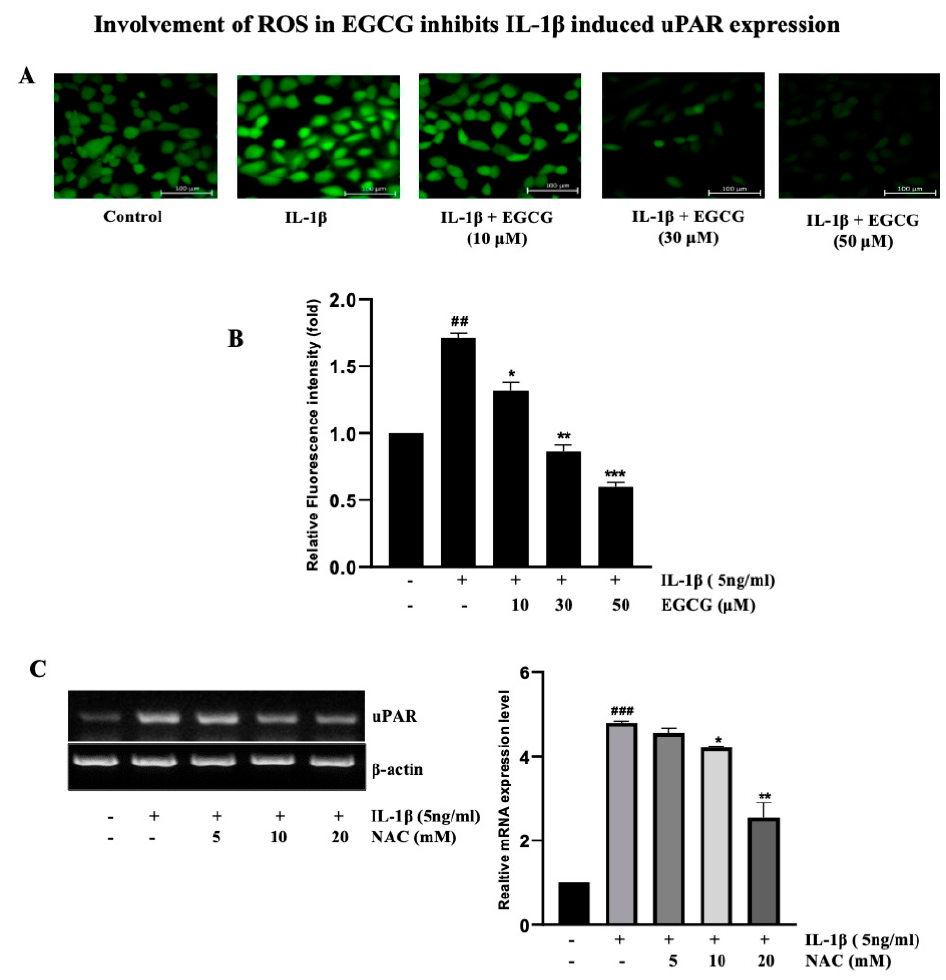
Figure 6. EGCG blocks ROS production induced by IL-1 β in T24 cells. ( A ) Representative images (200X) and statistically quantitative values of ROS production by confocal microscope. ( B ) Relative fluorescence intensity fold by EGCG and IL-1 β . ( C ) RT-PCR analysis for uPAR expression on NAC (5–20 mM) pretreatment for 1 h followed by 5 ng/mL IL-1 β treatment for 4 h. The above data represent the mean ± SD from triplicate measurements ( ## p < 0.01, ### p < 0.001, versus control; * p < 0.05, ** p < 0.01, *** p < 0.001 versus IL-1 β